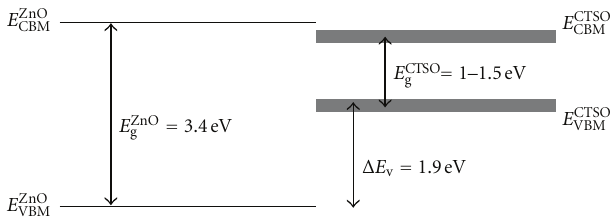
Figure 12: Band diagram of the ZnO/CTSO heterojunction deduced form the XPS